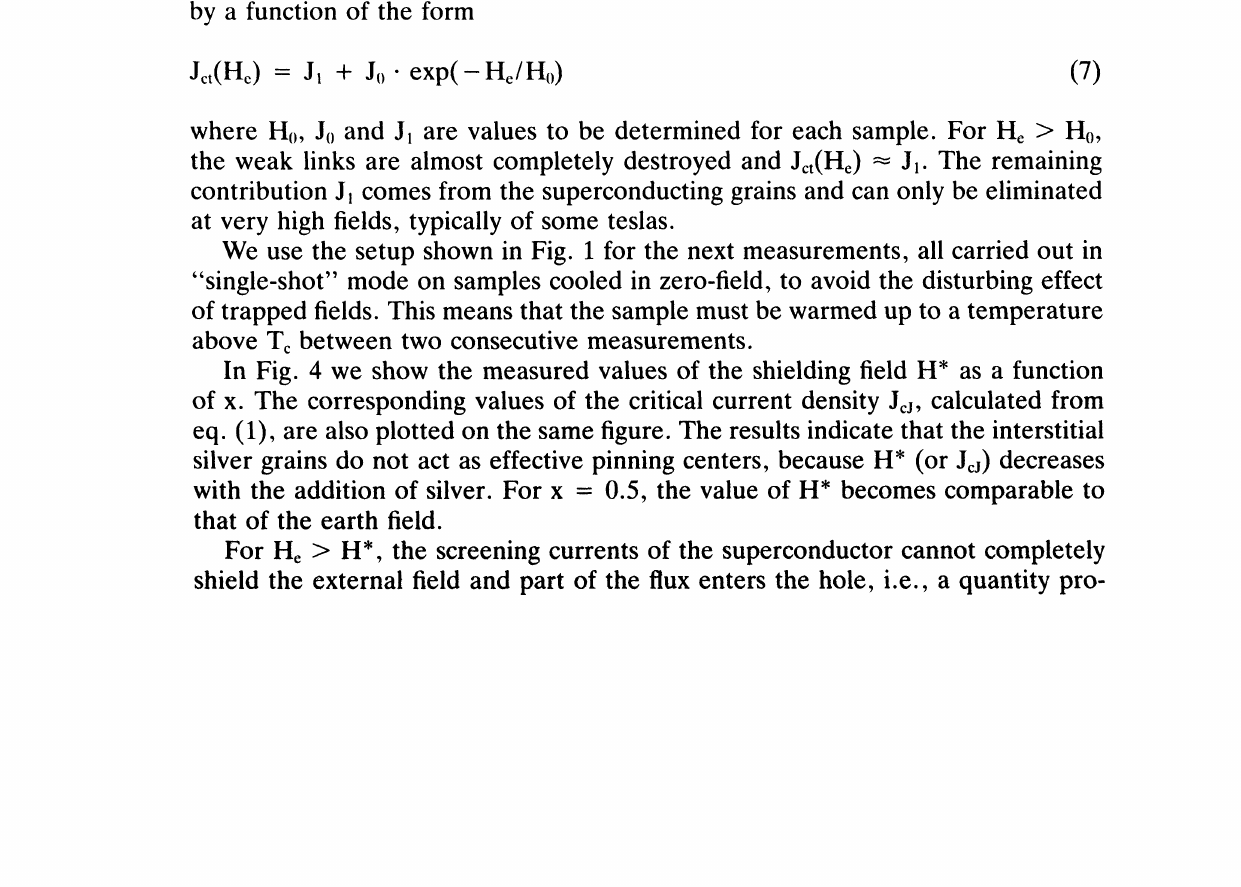
FIGURE 3 Critical transport current density Jc, vs. external field H for a sample with 30% Ag at T 77 K. Experimental data are fitted by a function of the form given in eq.